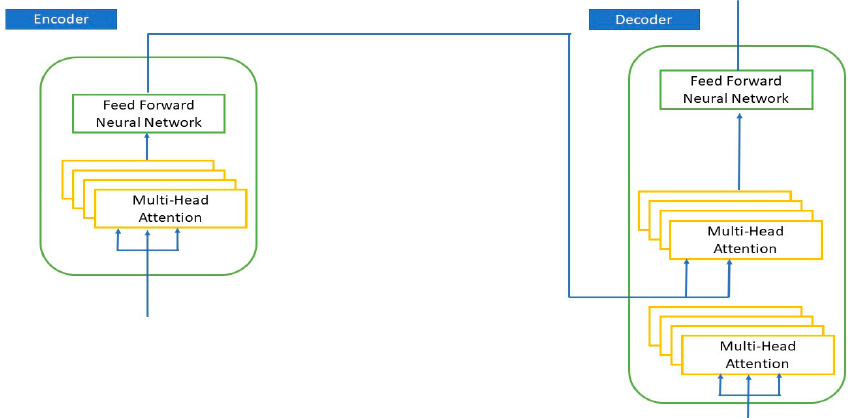
Figure 2. The encoder–decoder structure of the transformer architecture.